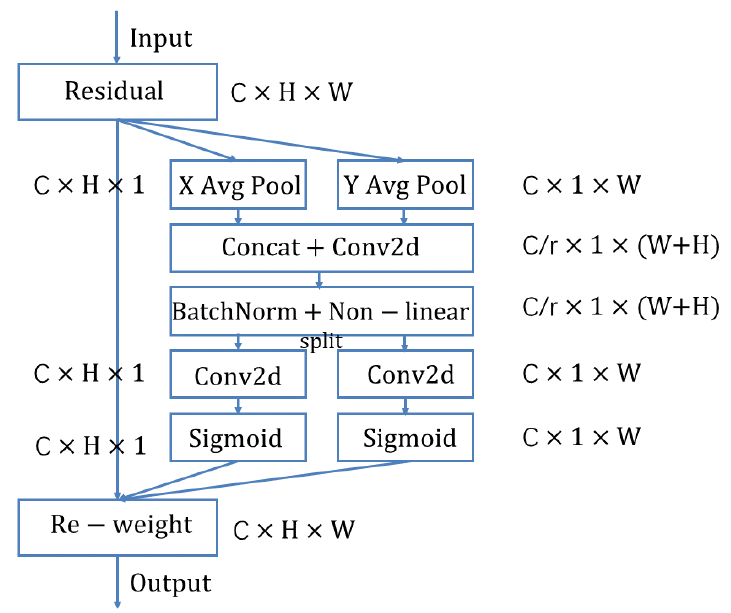
Figure 8. Illustration of position attention